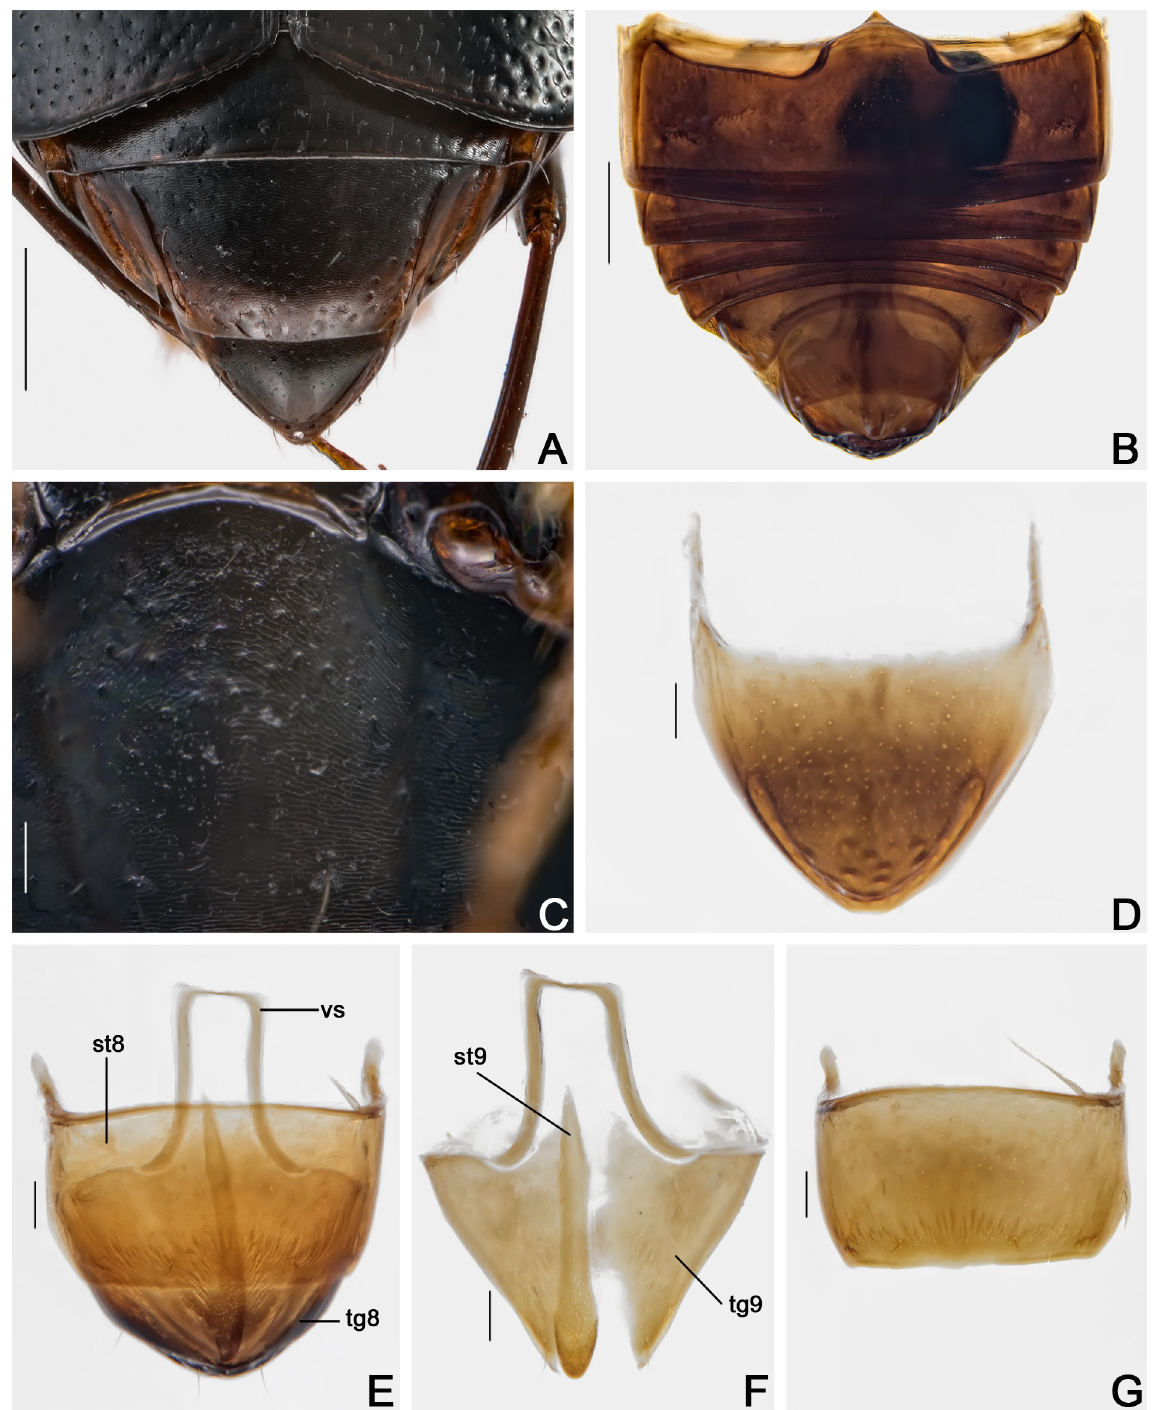
Fig. 11. Cyparium achardi sp. nov. A, C . Holotype, ♂ (CELC). B, D–G . Paratype ♂ (CELC). A–B . Abdomen, dorsal view (A) and ventral view (B). C . Ventrite 1. D . Tergite VIII. E . Terminalia. F . Tergite IX. G . Sternite VIII. Specimens collected at Mata do Paraíso, Viçosa (MG, Brazil). Abbreviations: st = sternite; tg = tergite; vs = ventral strut. Scale bars: A–B = 0.4 mm; C–G = 0.1